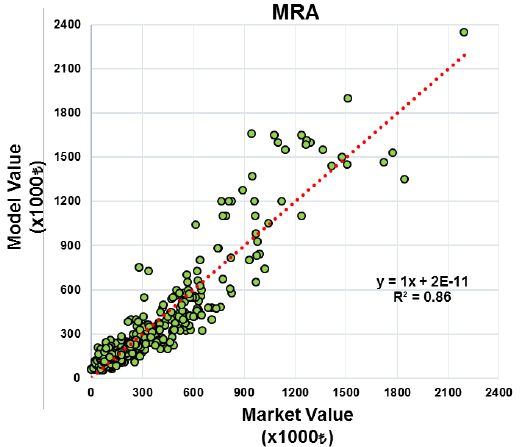
Figure 5 . Comparison of MRA model with market values